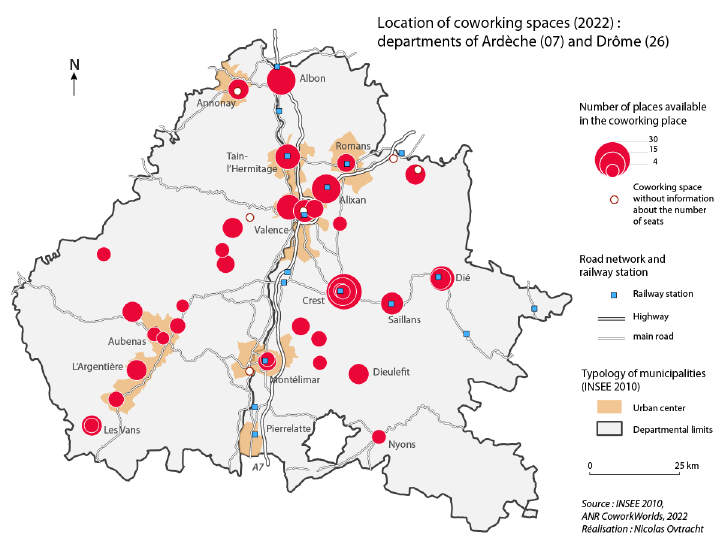
Figure 2: Map of CSs in Drˆome and